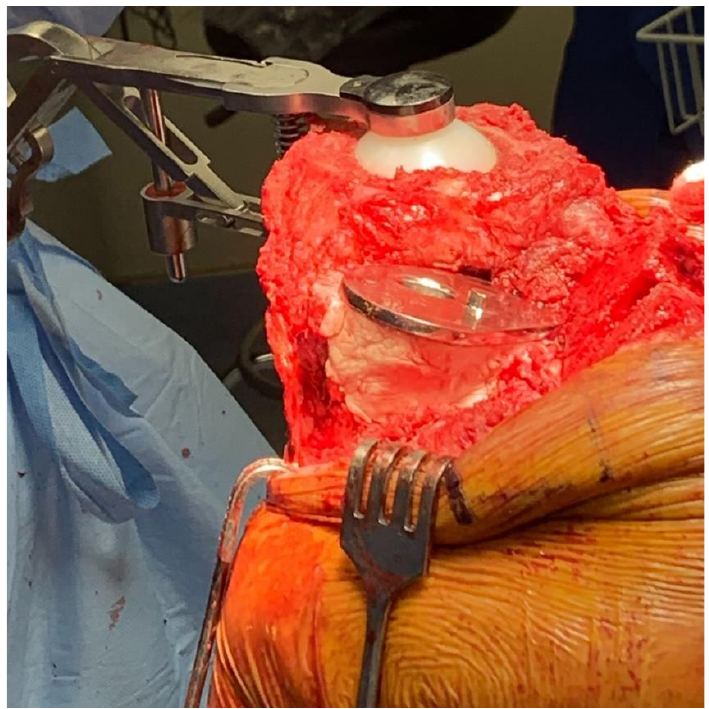
Figure 4. Underneath the tibial component, cement encompasses the metaphyseal cone and threaded Steinmann pins.